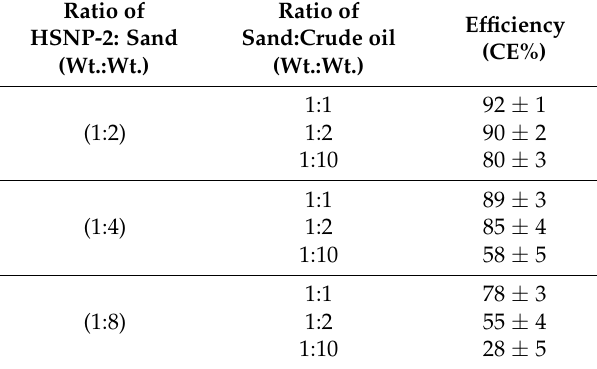
Table 2. Efficiency of the hydrophobic sand capped with HSNP-2 (prepared using 40 wt.% ASAS) for the collection of the oil spills from water surfaces.